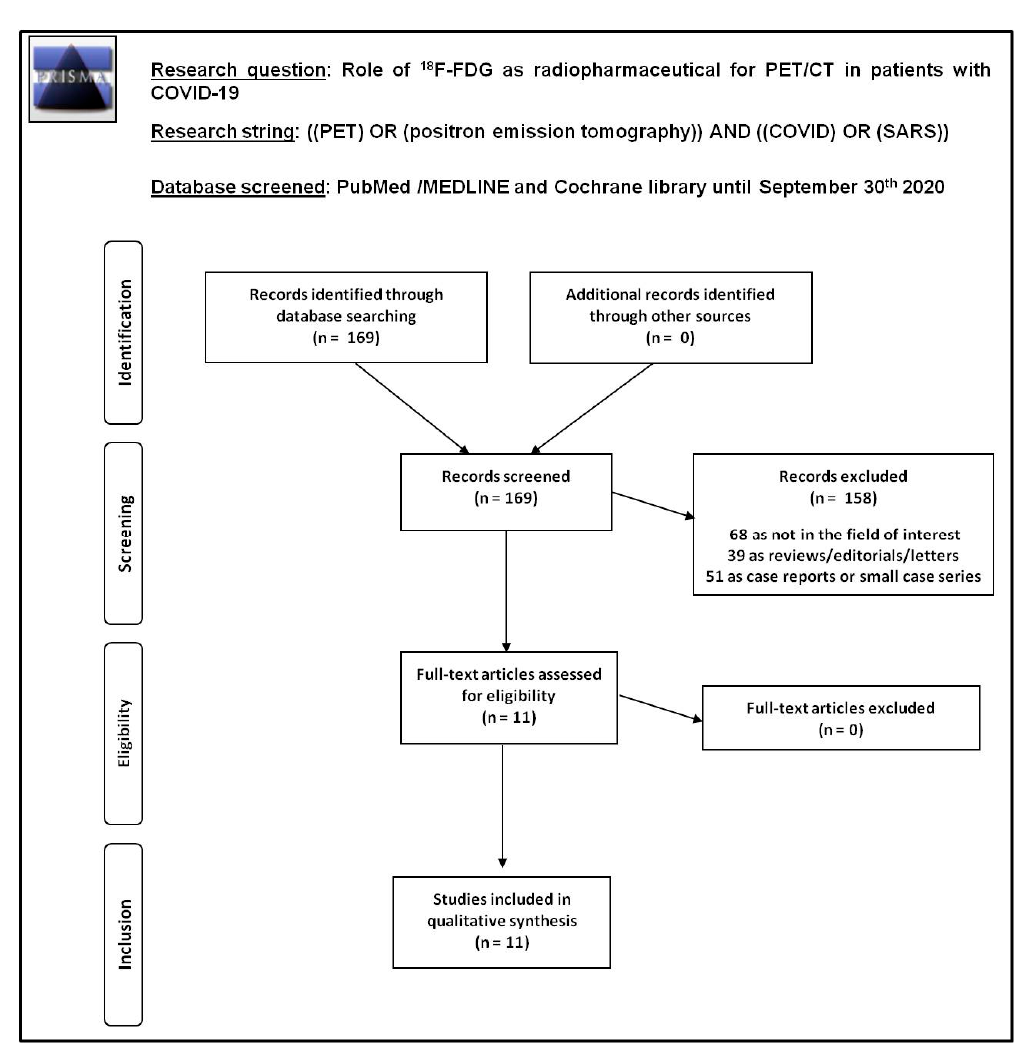
Figure 2. Flowchart of study selection and search results.